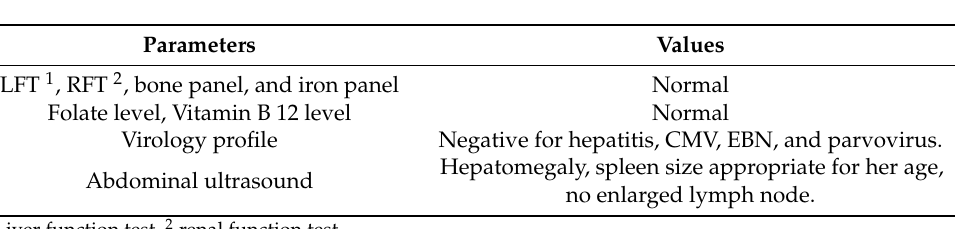
Table 4. Miscellaneous.